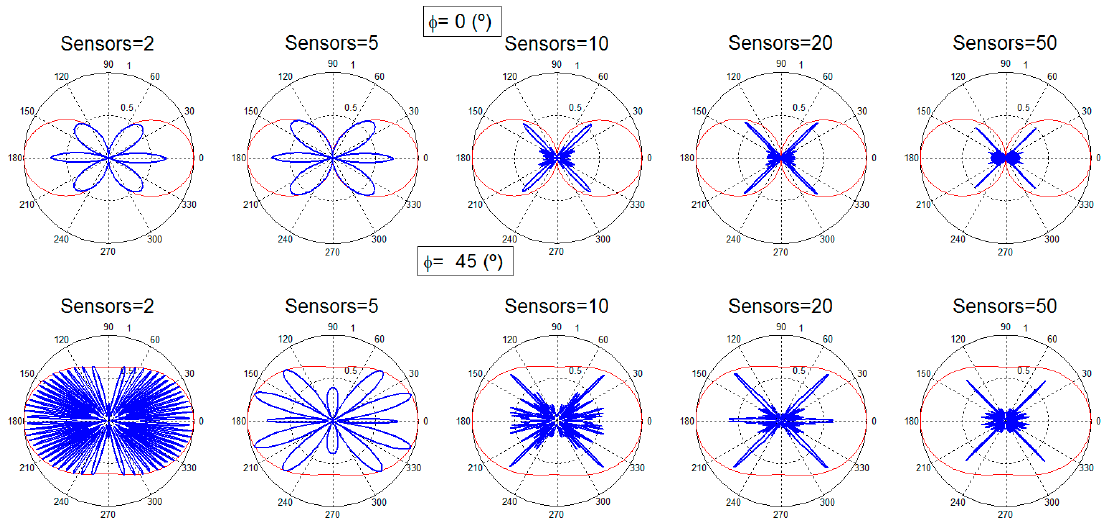
Figure 3. Radiation patterns for two, five, 10, 20 and 50 sensors, different search angles: dipole antenna.